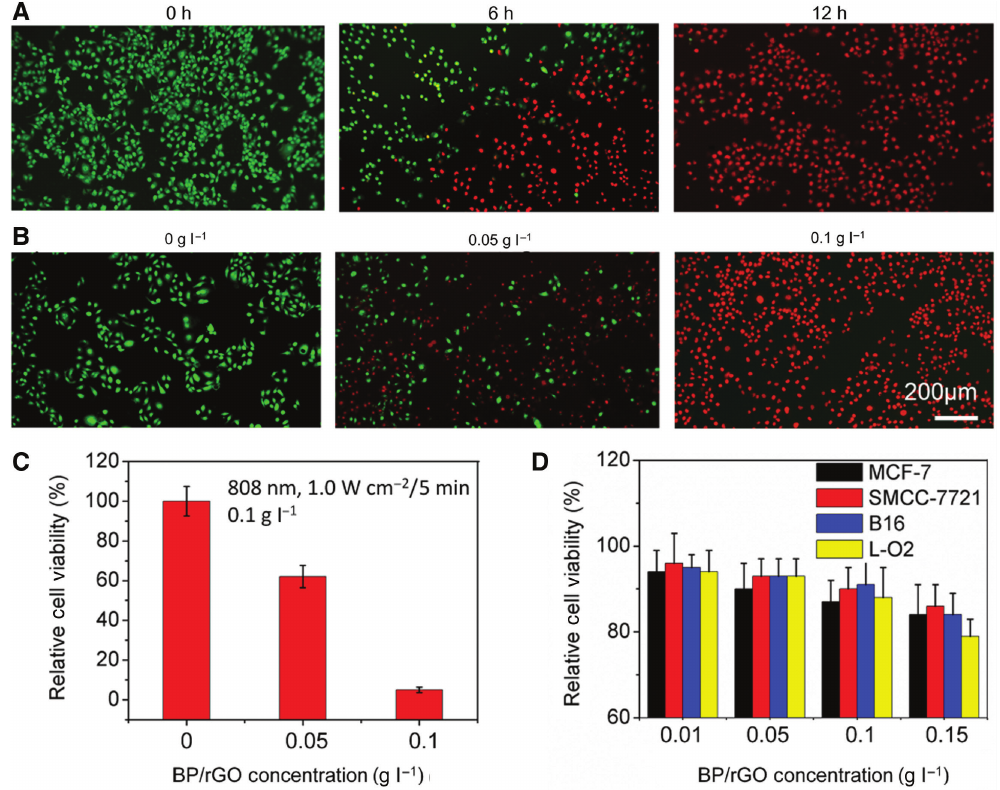
Figure 5: In vitro cellular experiments. (A) Fluorescence images of SMCC-7721 cancer cells stained with acridine orange (green, live cells) and propidium iodide (red, dead cells) upon the after incubation with 0.1 g l −1 of PEGylated BP/rGO and exposed to NIR laser (808 nm, 1.0 W cm −2 ) for 5 min; the photos were taken at different times (0, 6, and 12 h). (B) Dose-dependent PTT effect of PEGylated BP/rGO for SMCC-7721 cancer cells upon irradiation with NIR laser (808 nm, 1.0 W cm −2 ) for 5 min. Concentrations of PEGylated BP/rGO were 0, 0.05, and 0.1 g l −1 . (C) Relative viabilities of SMCC-7721 cells after photothermal eliminating of B). (D) Relative viabilities of MCF-7, SMCC-7721, B16, and L-O2 cells after co-incubation with different concentrations (0.01, 0.05, 0.1, and 0.15 g l −1 ) of PEGylated BP/rGO for 24 h. Error bars represent the standard deviations (SDs) calculated by three parallel